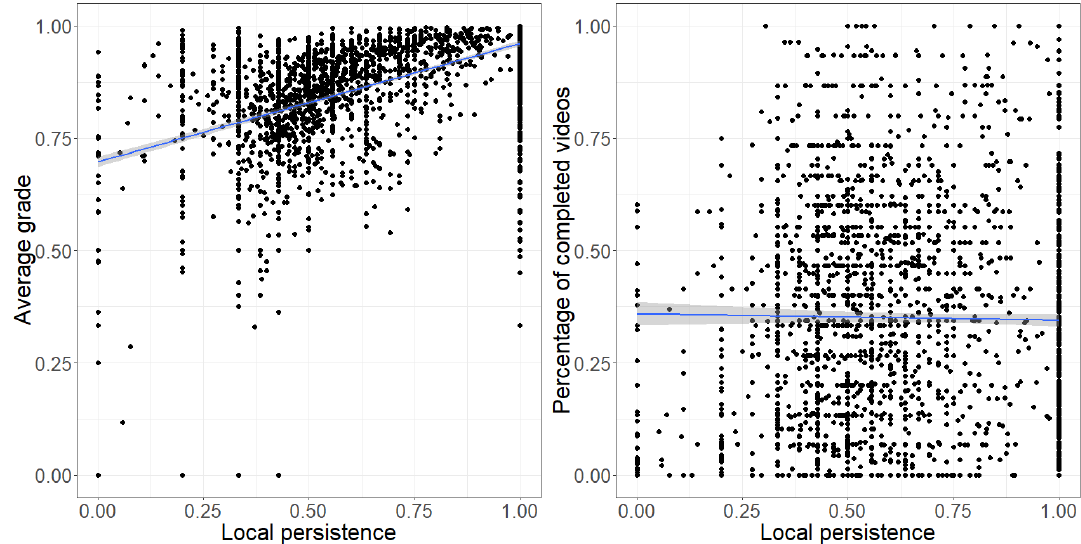
Figure 6. Relationship between local persistence and ( a: left ) average grade, ( b: right ) % of completed videos.